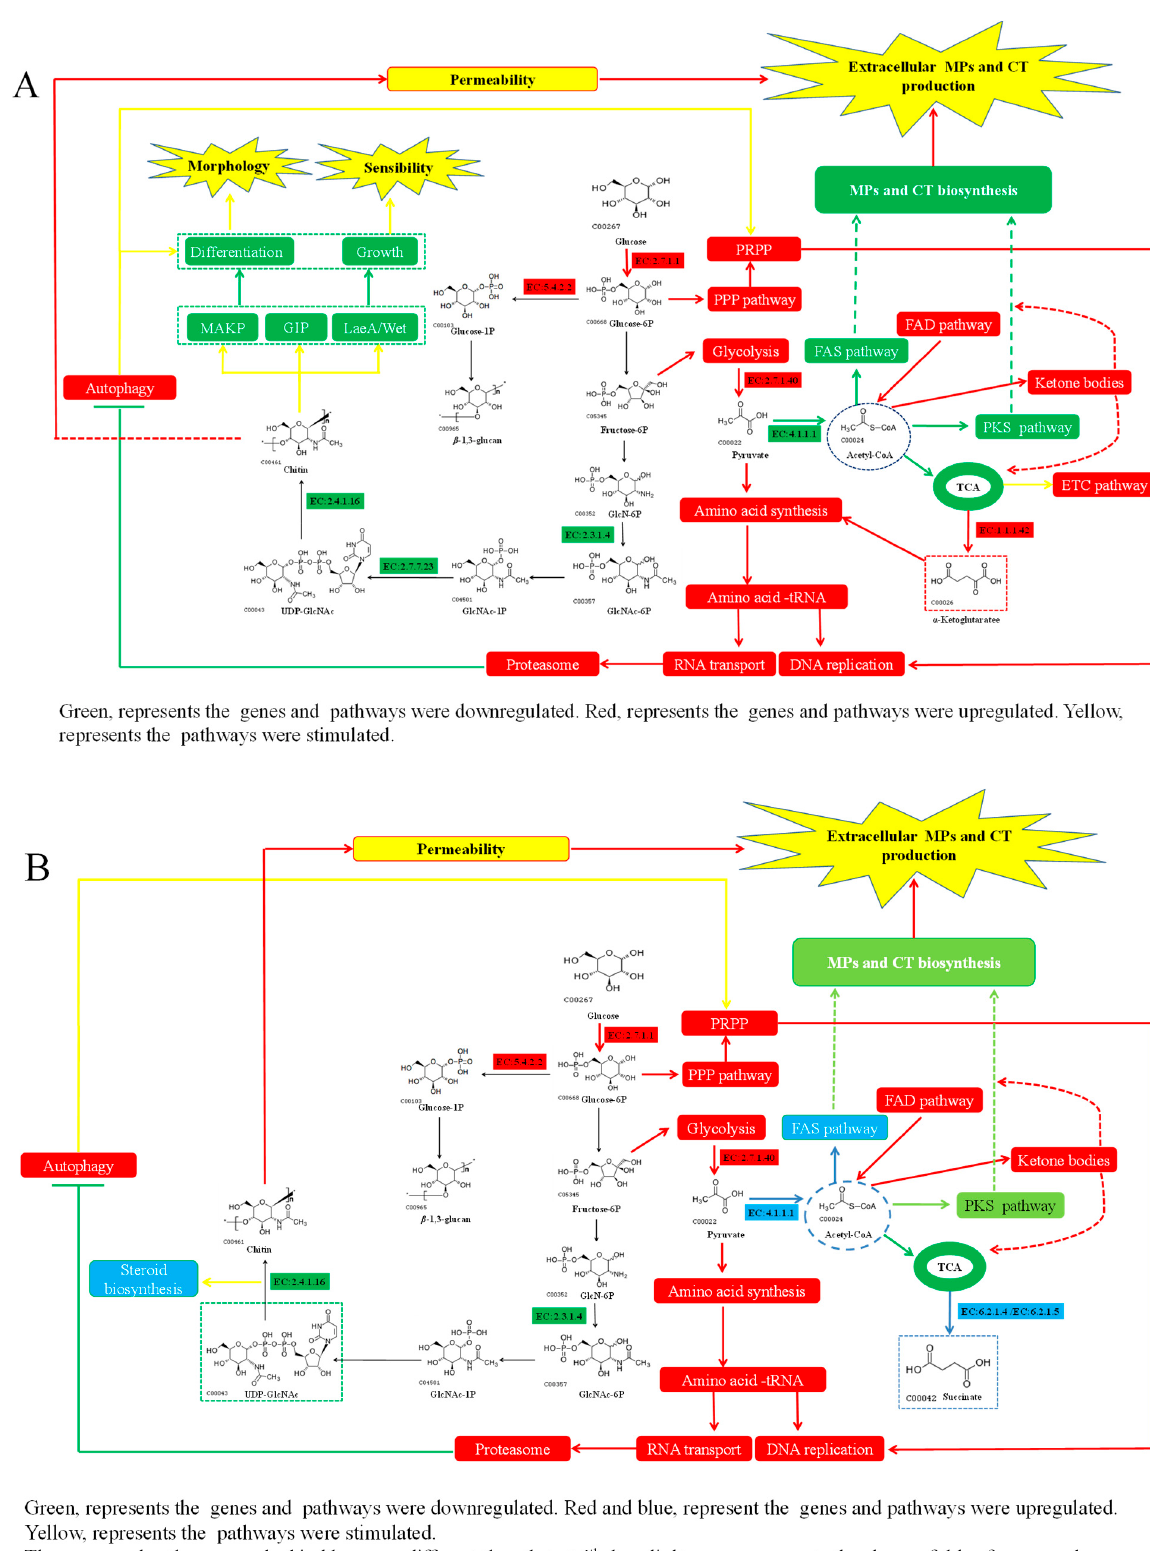
Figure 9. The regulated pathways after knockout of the chs 6 gene in parent strain M. purpureus LQ-6 during submerged fermentation at the fermentation prophase ( A ) and logarithmic stage of fermentation ( B ).